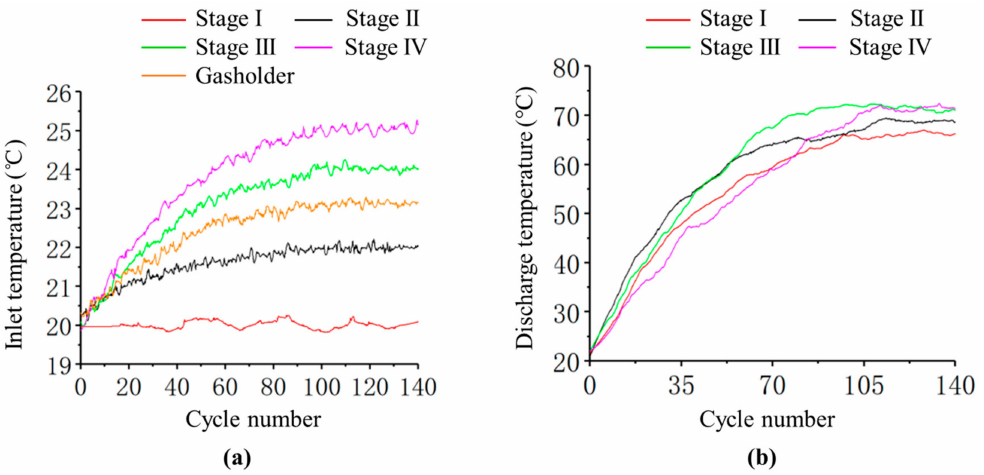
Figure 19. The ( a ) inlet temperature and ( b ) discharge temperature under the low load.